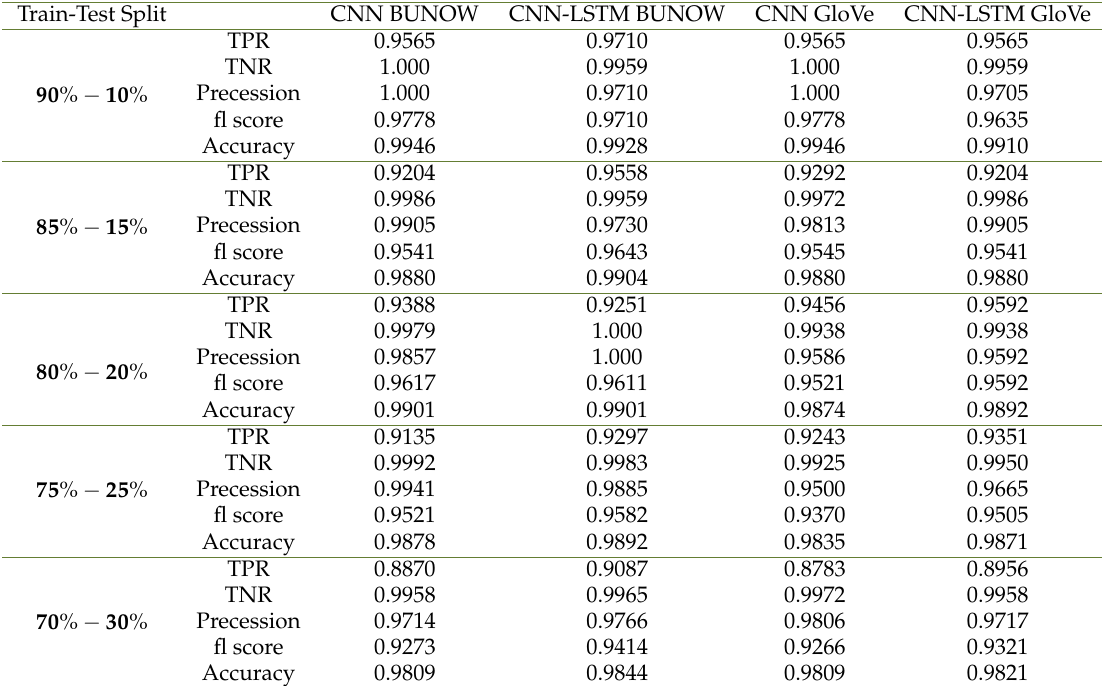
Table 2. Performance Measures for four